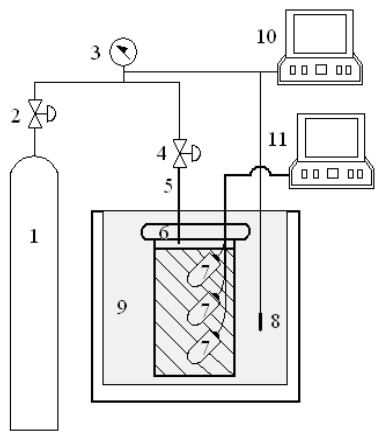
Figure 1. Schematic diagram of the experimental apparatus. 1. Gas cylinder; 2. Gas valve;